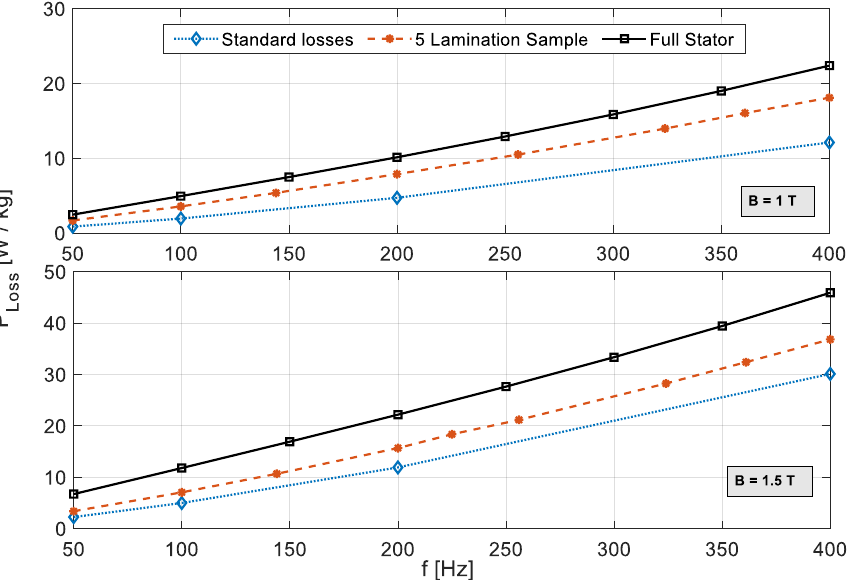
Figure 17. Comparison between the measured specific core for the different samples at different frequencies and different magnetic induction levels.